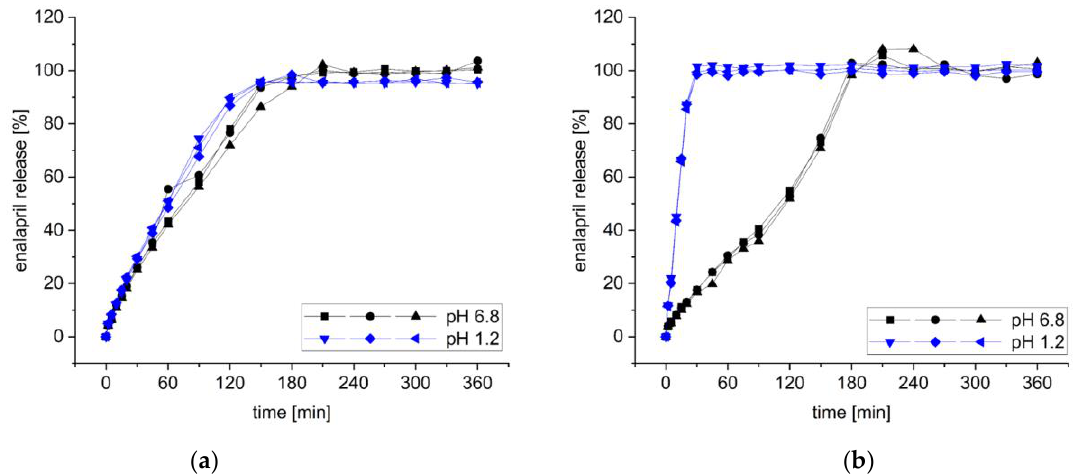
Figure 12. Dissolution behaviour of extrudates with SOL ( a ) and bPMMA ( b ) in basket apparatus in phosphate buffer pH 6.8 and 0.1 N hydrochloric acid ( n = 3). Formulation F5 with bPMMA extruded at 70 ◦ C released 17.39 ± 0.57% after 30 min and 100% after 180 min in phosphate buffer pH 6.8 (100.19 ± 2.47%). However, when released in 0.1 N hydrochloric acid, 99.87 ± 1.56% enalapril was released after 30